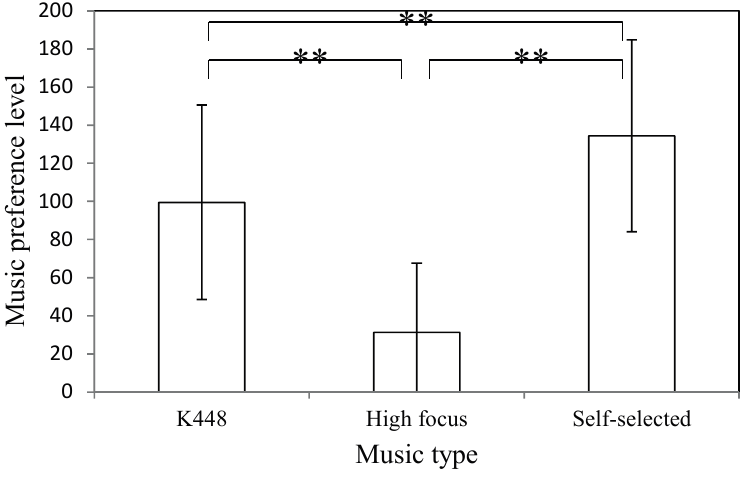
Figure 5. Music preference level corresponding to different types of music. Here, ** denotes